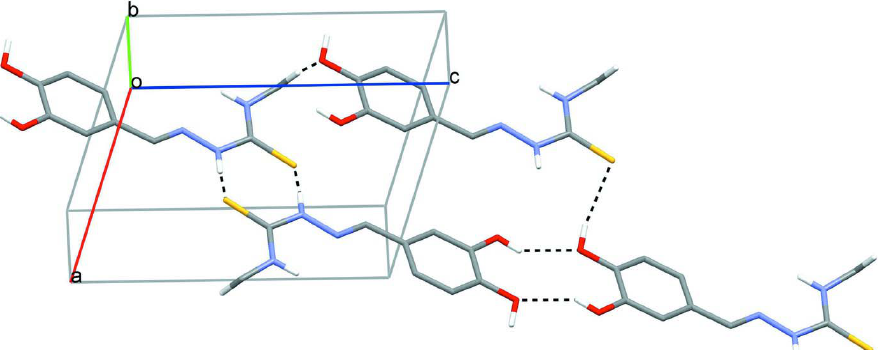
Figure 1 The structure of (I), with atom labels and 50% probability displacement ellipsoids for non-H atoms. An intramolecular hydrogen bond is drawn as a dashed line.